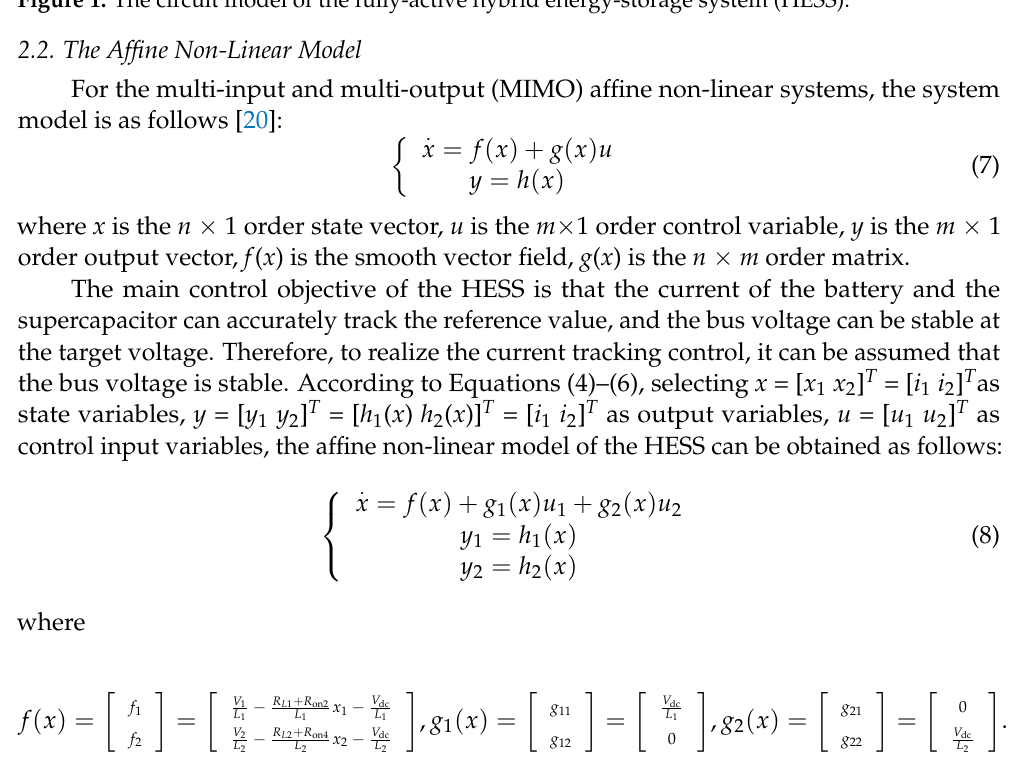
Figure 1. The circuit model of the fully-active hybrid energy-storage system (HESS).